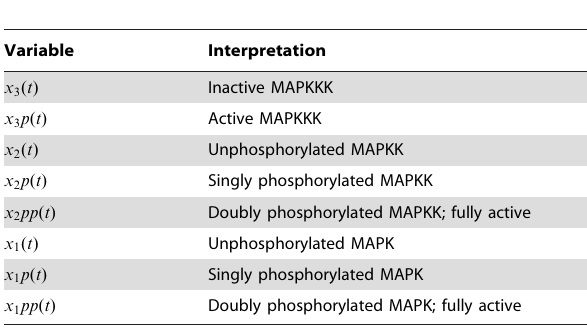
Table 1. State Variables of the MAPK